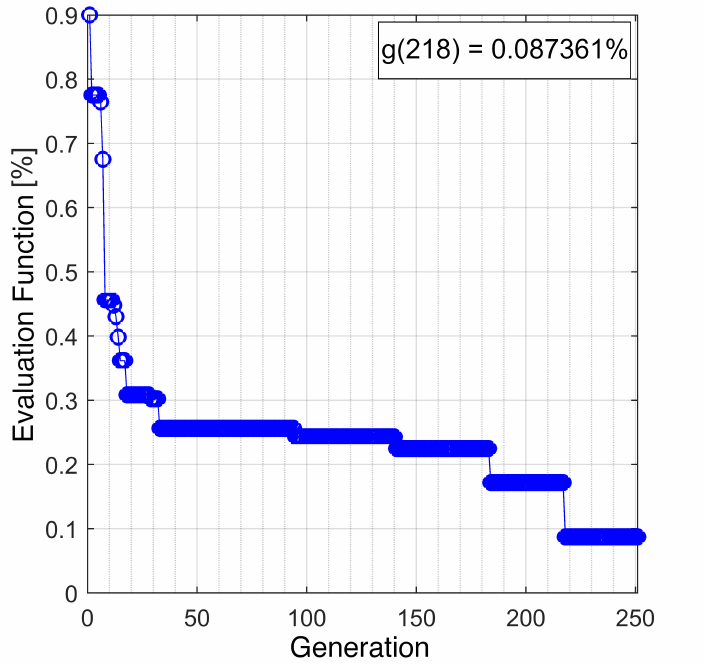
Figure 10. Presentation of the evaluation function values in the fuzzy controller optimization